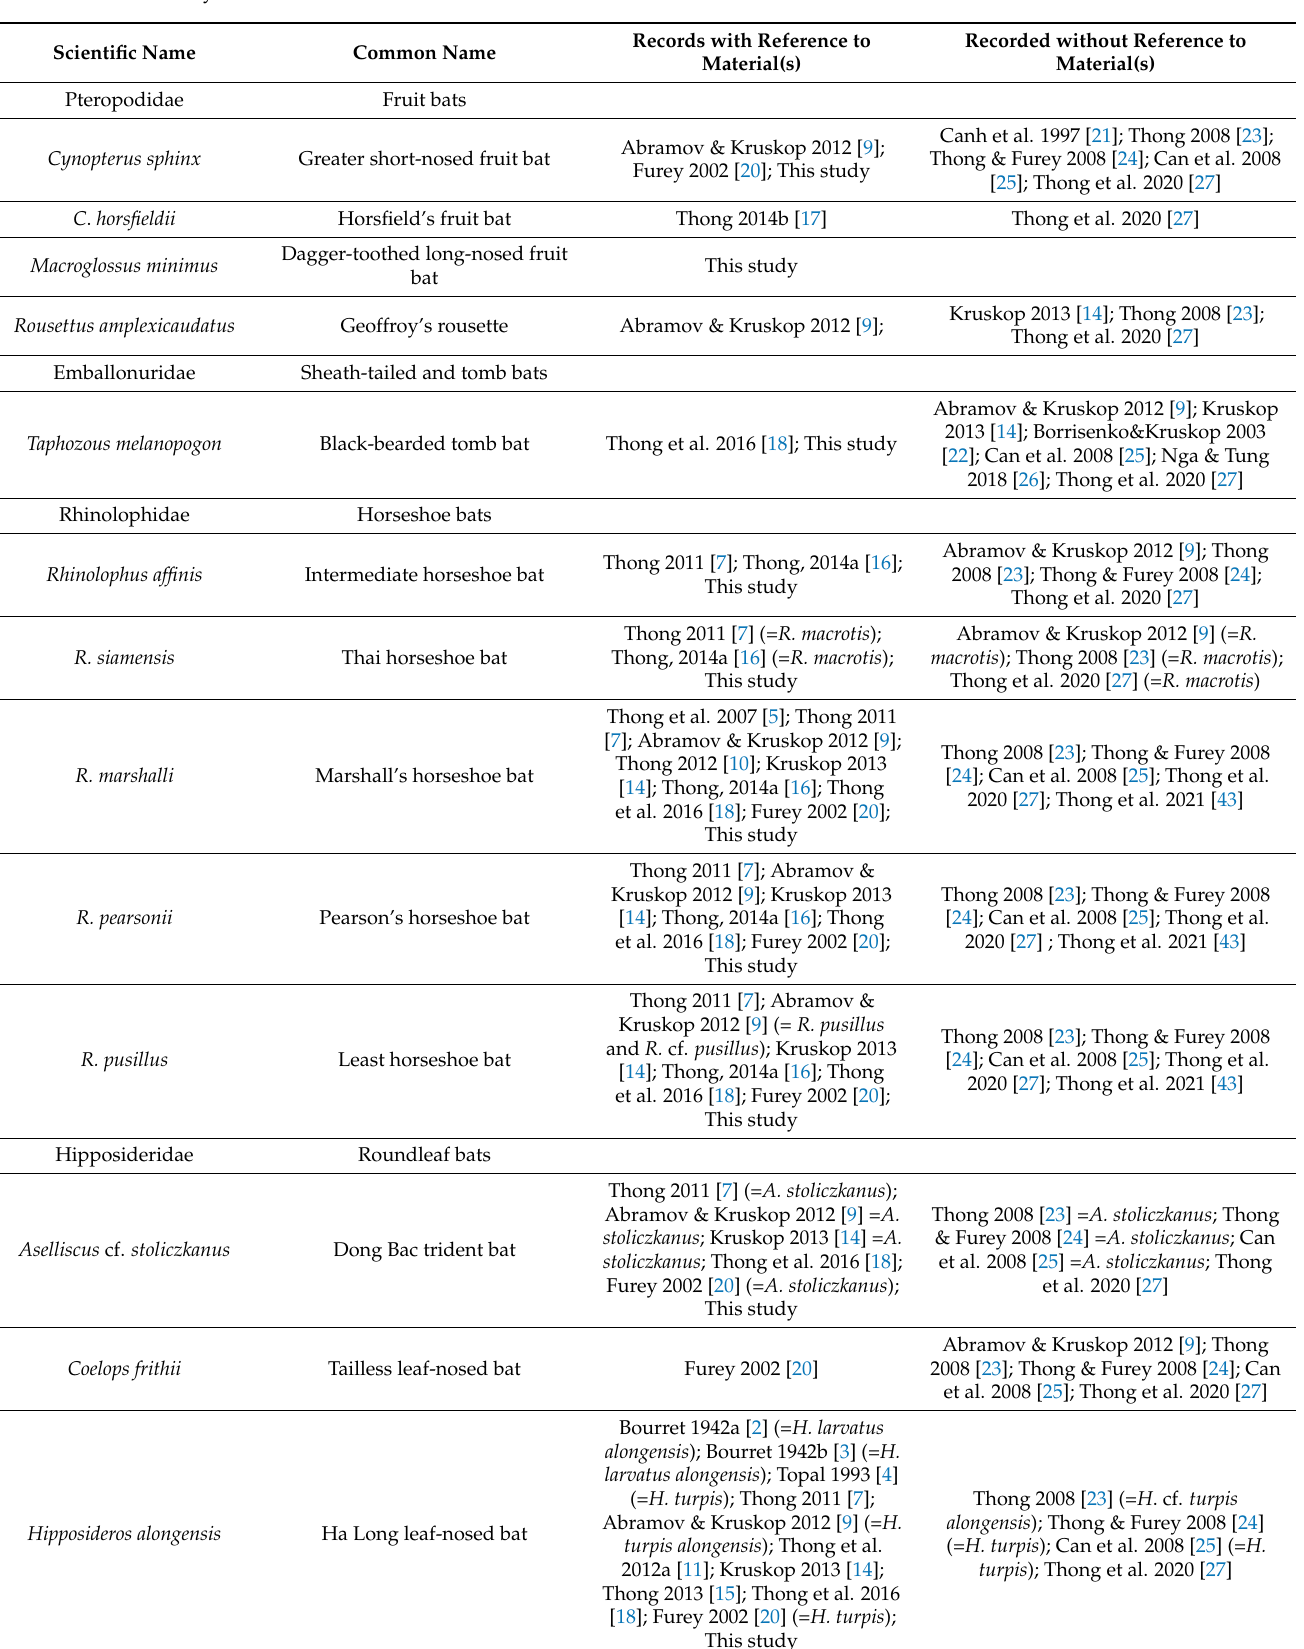
Table 4. A confirmed bat species composition in Cat Bat Biosphere Reserve, Northeastern Vietnam, based on data from